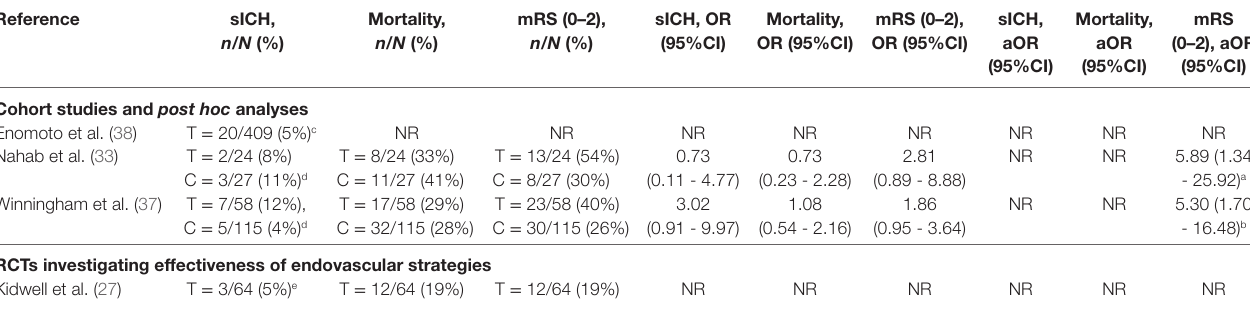
taBLe 6 | Outcomes of included studies investigating periprocedural heparin use in patients with ischemic stroke who underwent acute mechanical thrombectomy. Reference